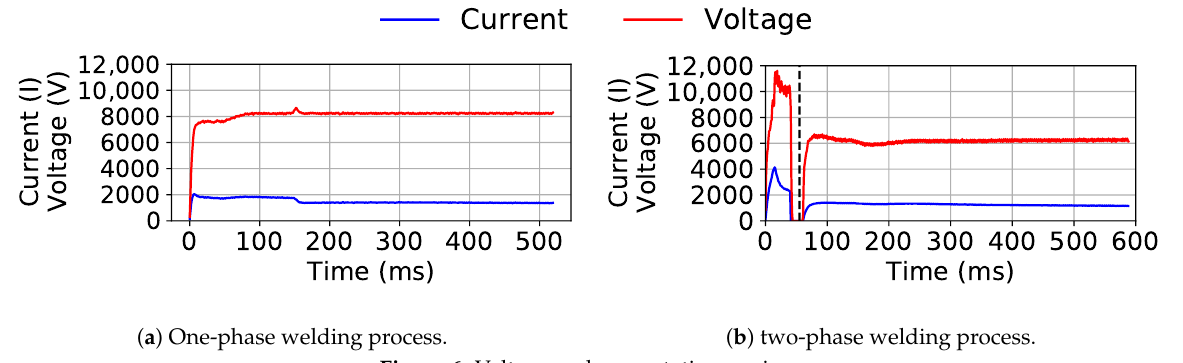
( b ) two-phase welding process. Figure 6. Voltage and current time-series.